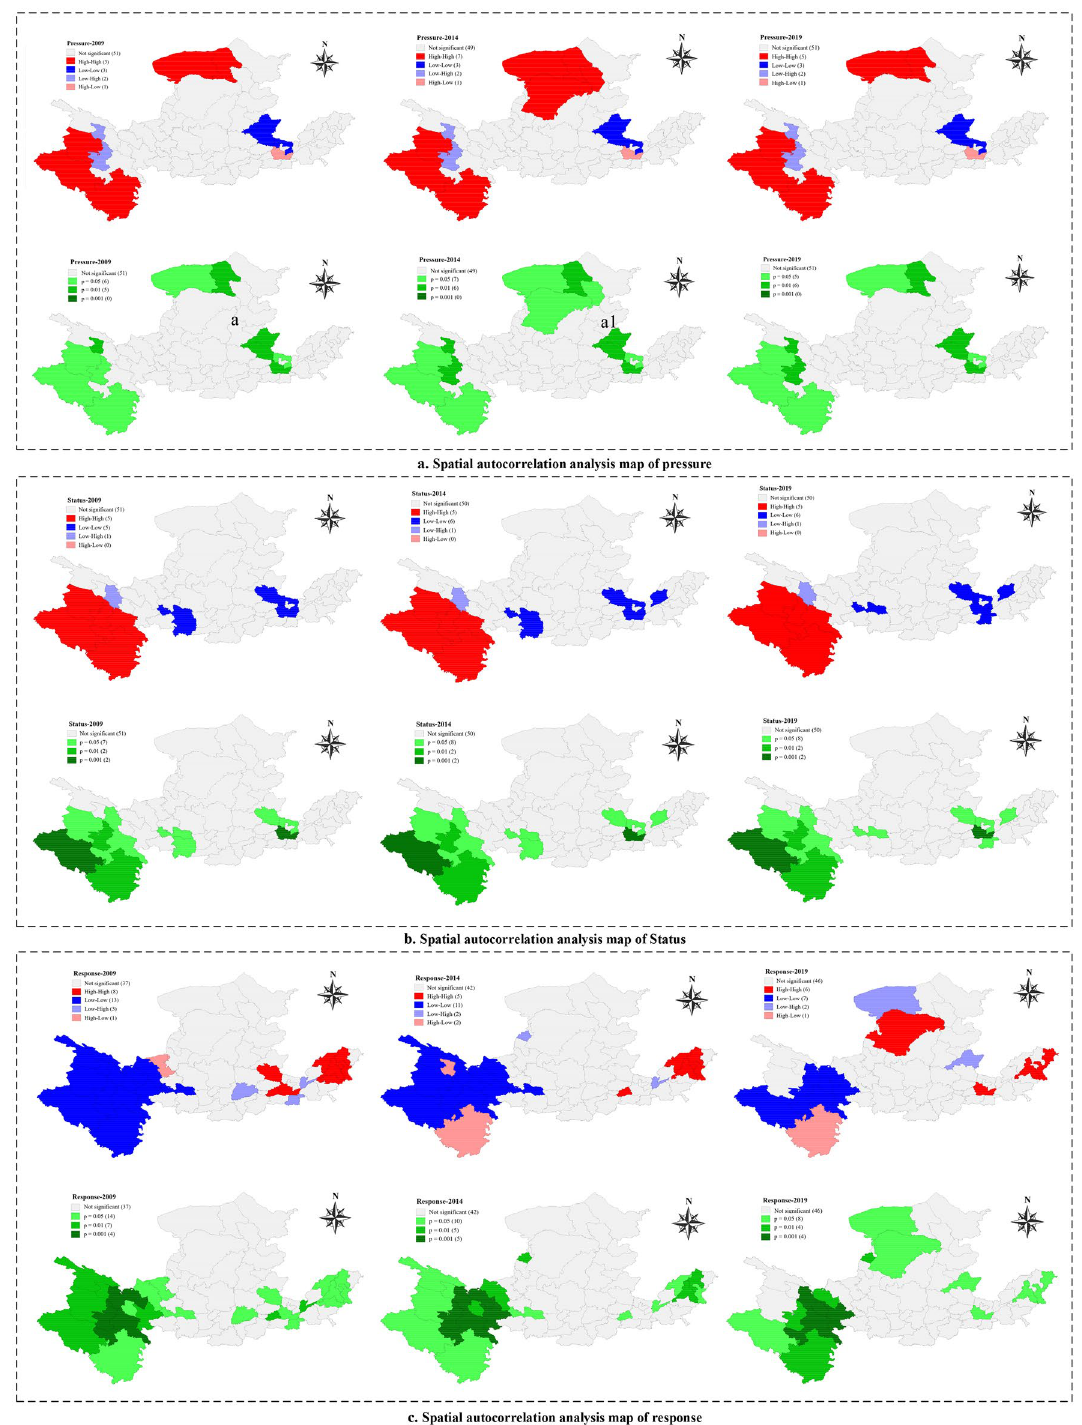
Figure 8. ( a ) Spatial autocorrelation analysis map of pressure, ( b ) Spatial autocorrelation analysis map of state, ( c ) Spatial autocorrelation analysis map of response. Note This was created by Geoda, version 1.18.0. https:// geoda center. github.